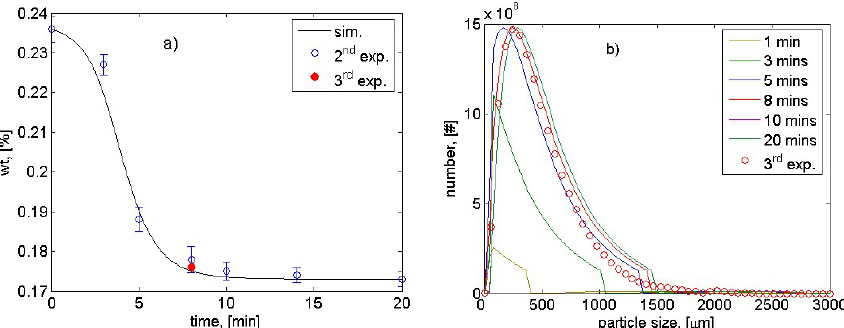
Figure 8. ( a ) Solute concentration change during crystallization; ( b ) CSD evolution versus time. The 3rd experiment as a validation was stopped at 8 min (see “ • ” and “o” symbols in Figure 8a,b, respectively).